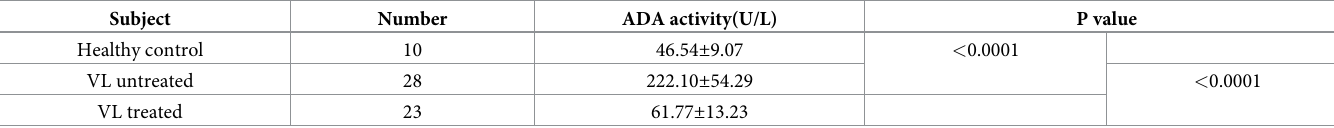
Table 2. Serum ADA activity of active VL cases before and after treatment (Serum ADA activity (A) of healthy subject (n = 10), VL untreated (n = 28) and VL treated (n = 23)).